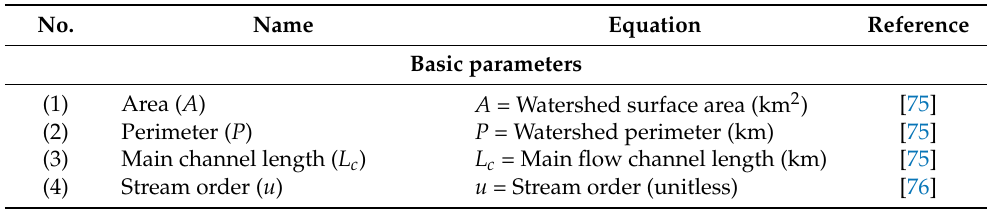
Table 1. System of methods and principles used for the computation of the geomorphometric parameters of basic and